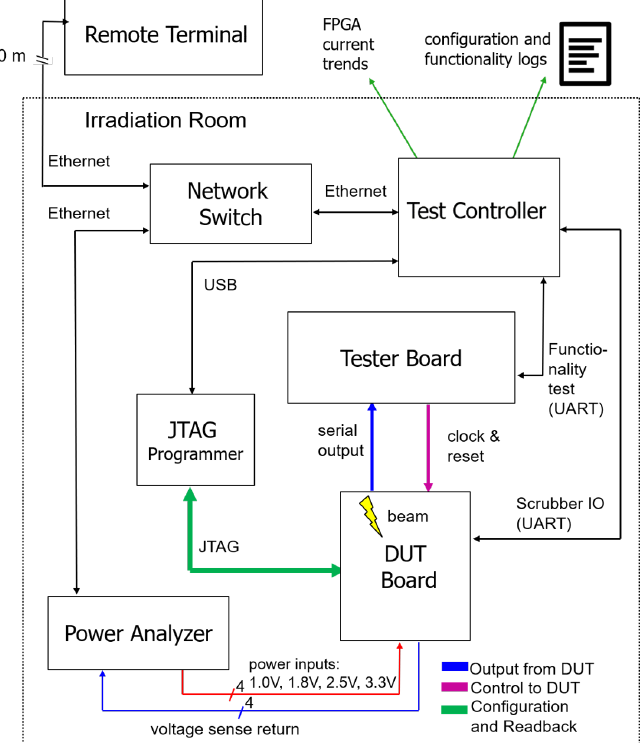
Figure 6. Schematic diagram of the instrumentation used for the